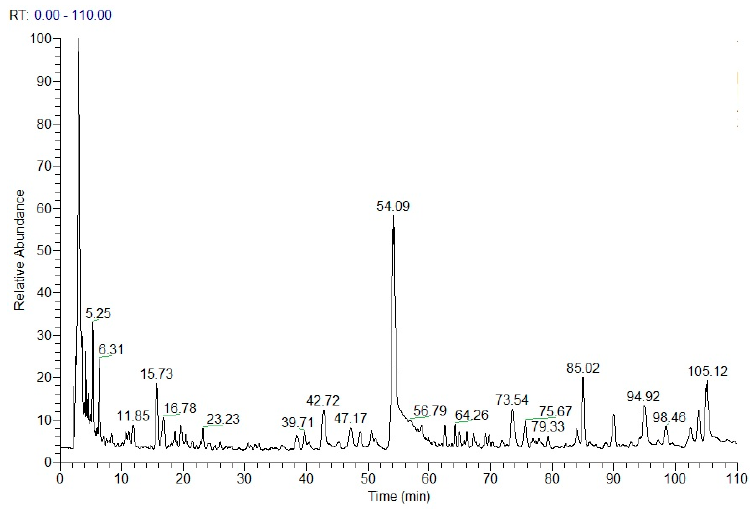
Figure 6. TIC of S5. Table 1. Identification of potential constituents in Qingwen Baidu Decoction.